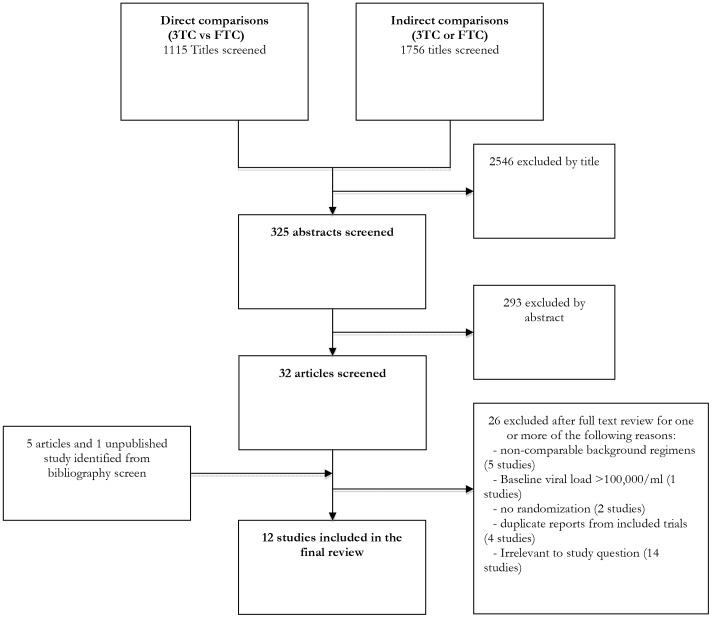
Study flow chart.